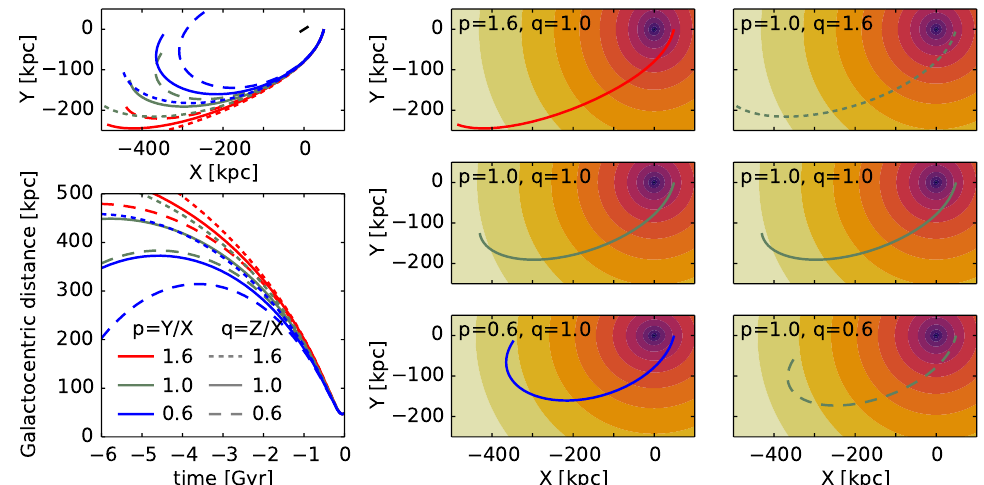
Figure 4. Past trajectory of the LMC for different choices of the Milky Way halo shape parametrised Y / X and q Z / X , where the orientation of the coordinate system is such that by the axis ratios p ≡ ≡ the LMC is currently located on the X axis and its angular momentum points in the Z direction. The Galactic potential has the same spherically averaged mass profile in all cases, with the total mass being M MW = 0.95 10 12 M , and the LMC follows a test-particle orbit; the spherically symmetric case is × (cid:12) identical to the one shown by the black curve in Figure 3. The trajectory plane X – Y is approximately perpendicular to the Galactic disc, which is shown by a black dash in the top left panel. The orbits for nine different combinations of p and q are shown by different colours and dashes. Centre and right columns show the equipotential contours for different choices of p and q , and the corresponding orbits. The strong variation of orbital period and the apocentre radius is caused by the changes in the value of the potential at the current location of the LMC. This is more apparent for the centre column, where making the halo more flattened in the Y direction (from top to bottom) stretches the equipotential surfaces horizontally, thereby lowering the value of the potential on the X axis. On the other hand, increasing the flattening in the Z direction (right column, from top to bottom) leaves the equipotential contours nearly round, but lowers the potential in the entire X – Y